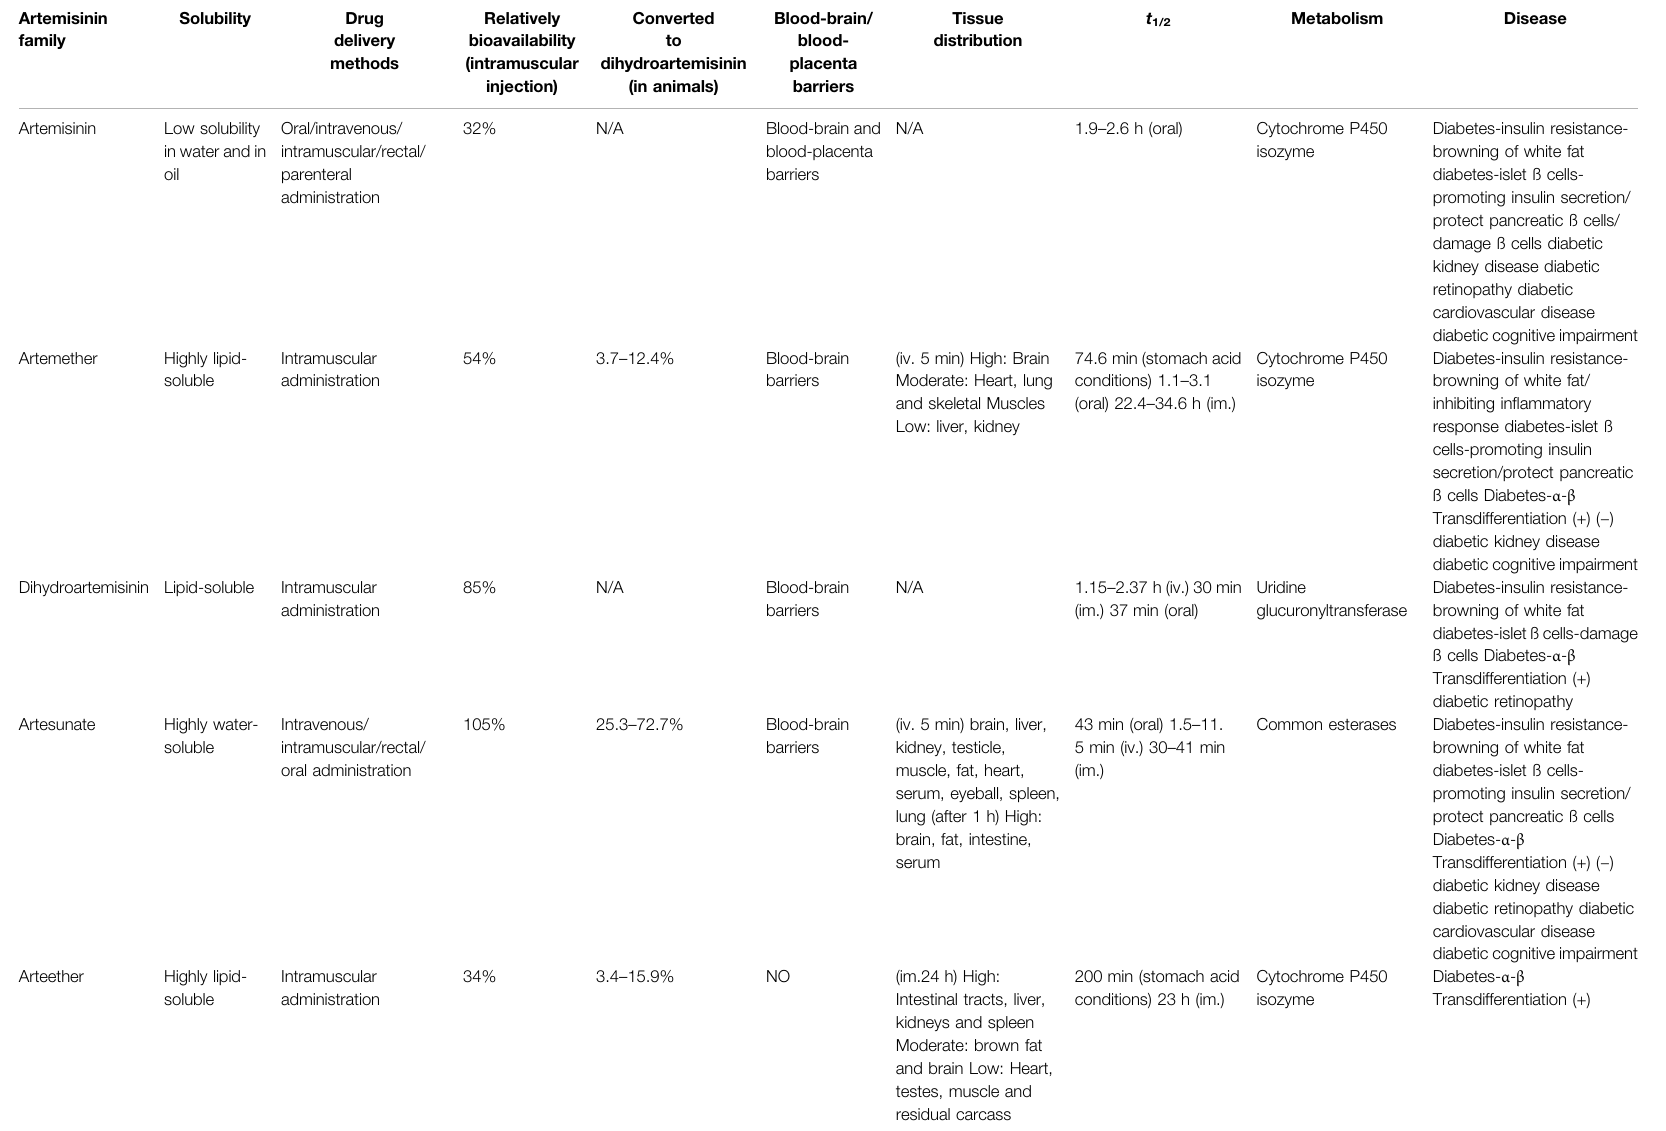
TABLE 3 | The properties of artemisinin and its